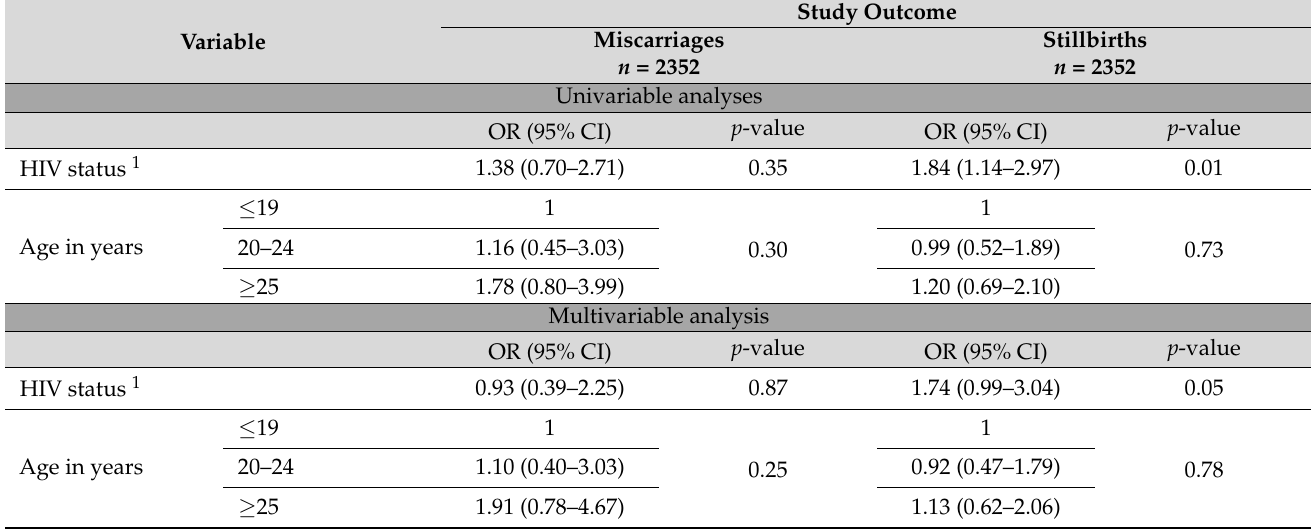
Table 3. Univariable and multivariable analyses: adverse pregnancy outcomes.